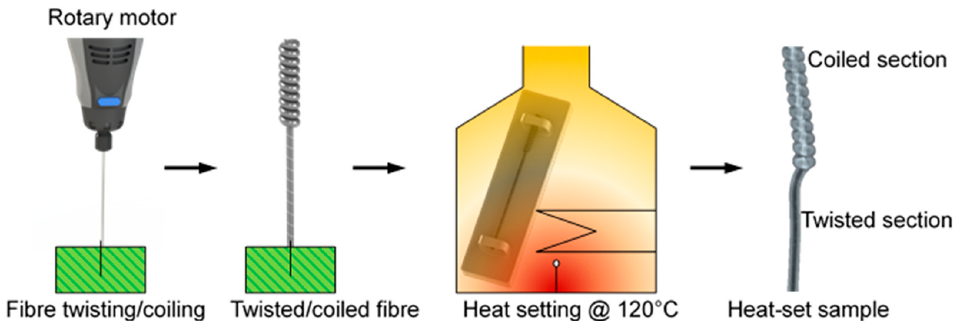
Figure 1. Fabrication method of a coiled